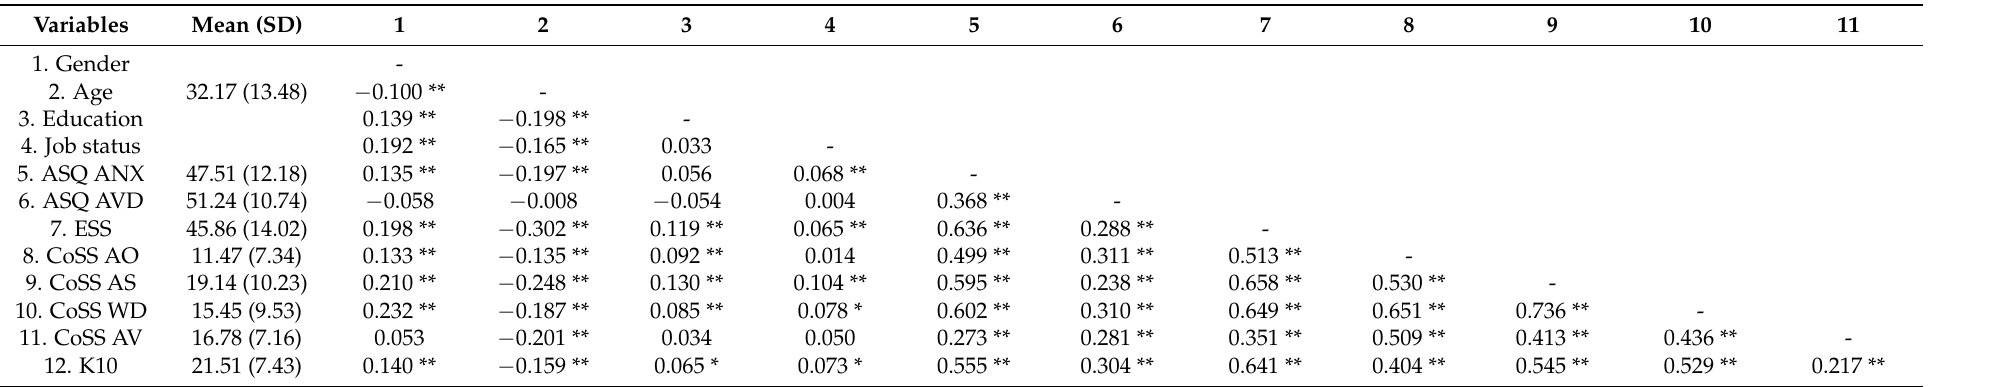
Table 1. Means, standard deviations and Pearson’s correlations ( n =